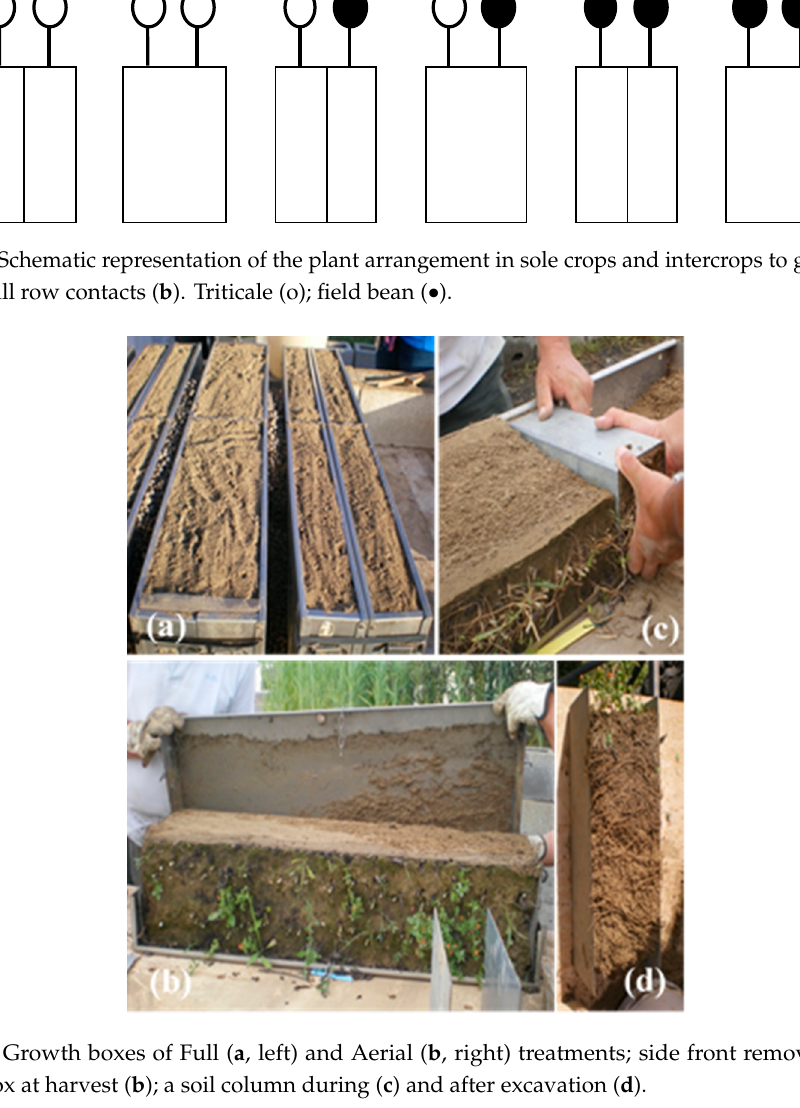
− 1 17.3 g kg (Walkley and Black method), total CaCO 3 5.4 g kg